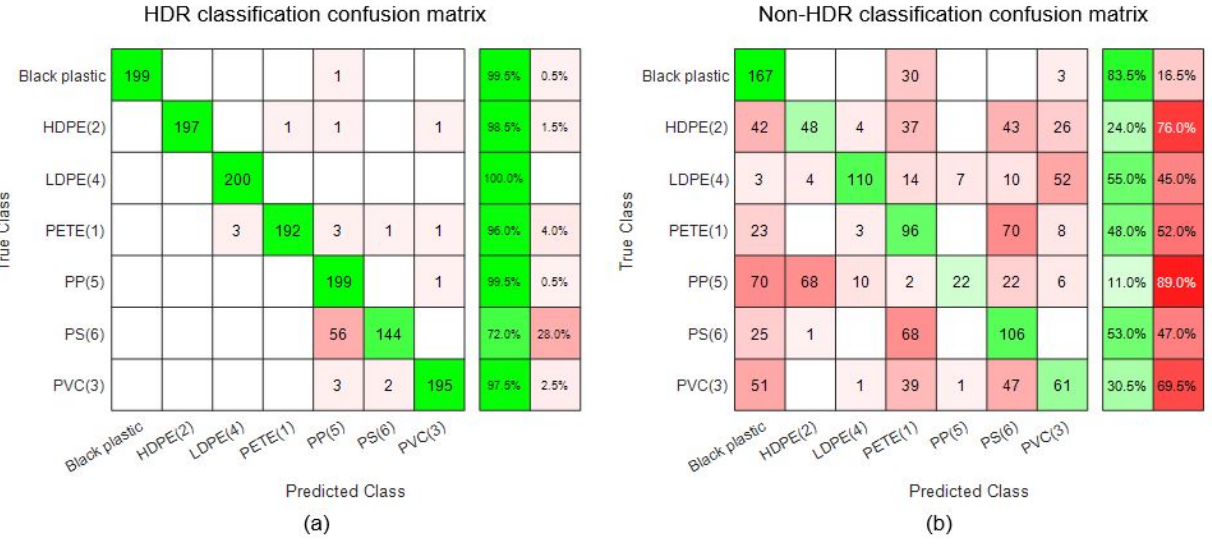
Figure 14. Classification results for test case 2: ( a ) HDR classification confusion matrix, ( b ) nonHDR classification confusion matrix.